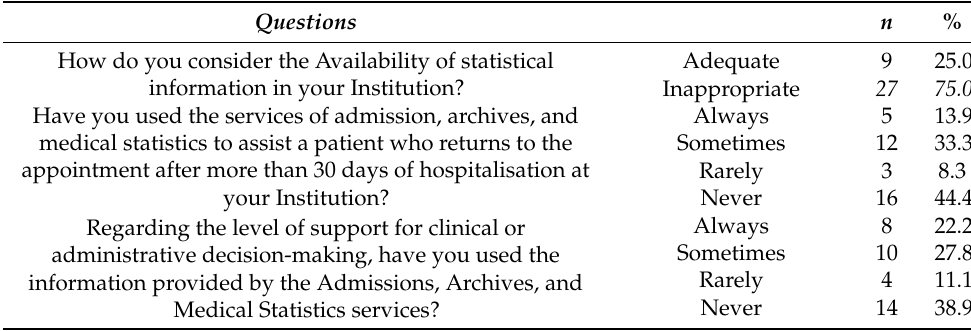
Table 3. Use of information for decision-making (clinical and administrative) ( n = 36).